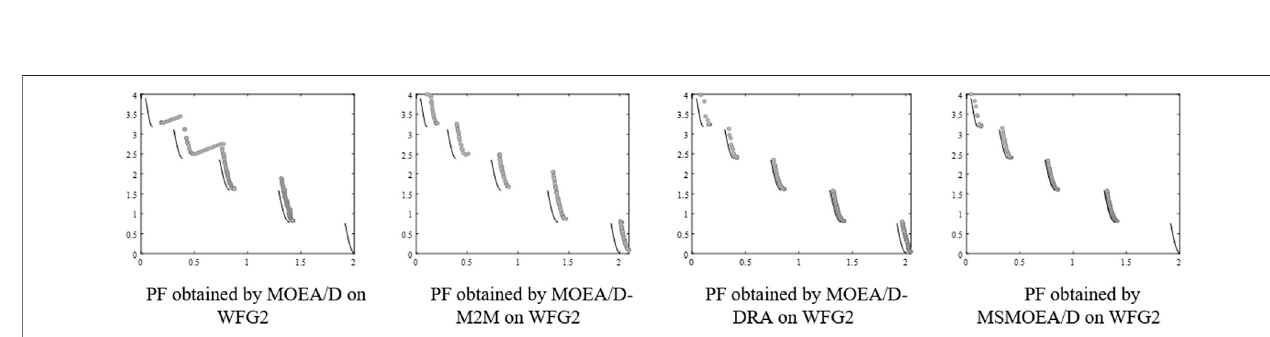
FIGURE 9 | PF obtained by MSMOEA/D and MOEAs on two-objective WFG1.